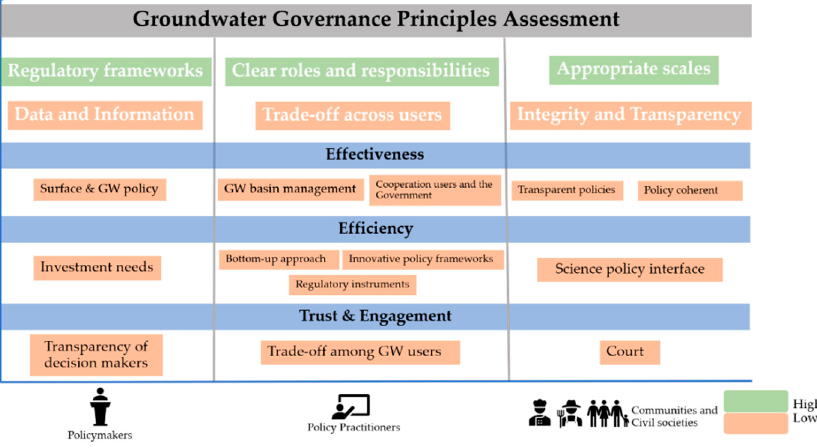
Figure 4. Groundwater Governance Principles Assessment.